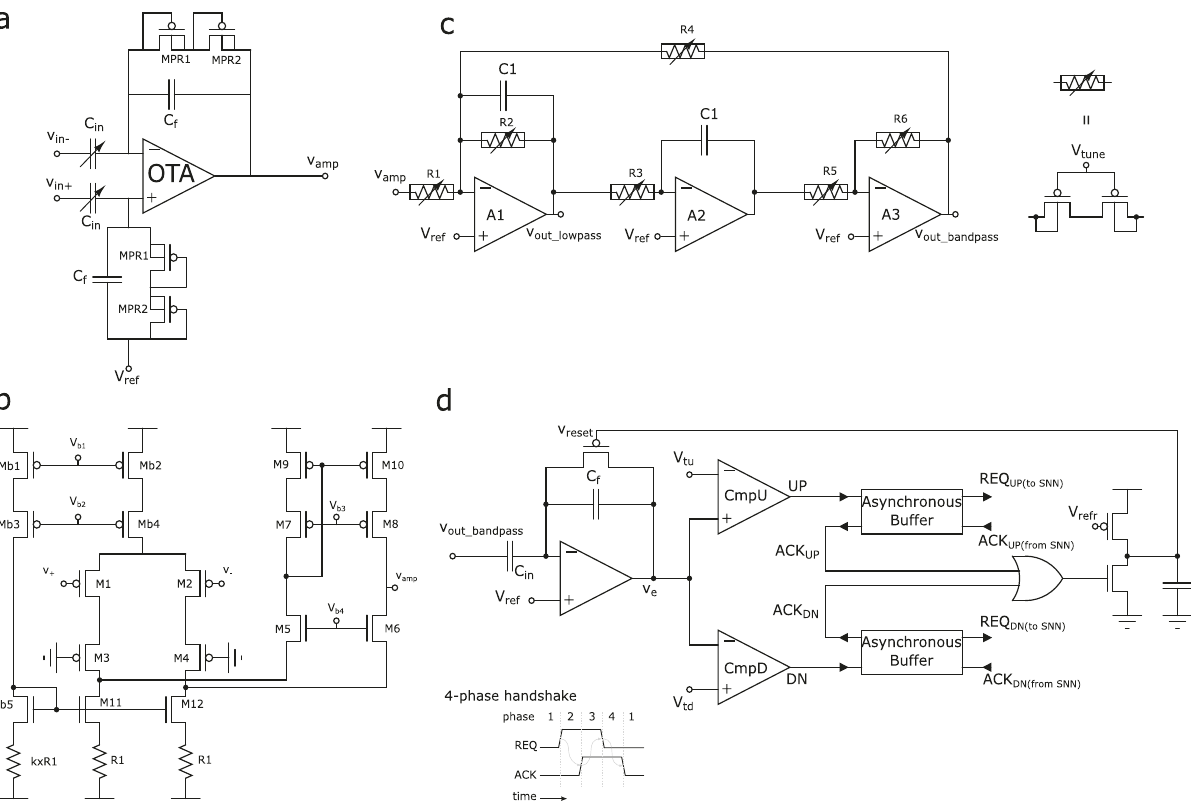
Fig. 3 Schematic diagrams of the input headstage circuits. a Variable-gain LNA using variable input capacitor array and pseudo-resistors. The gain of this stage is calculated by C in / C f ; the use of the pseudo-resistors allows to reach small low cut-off frequencies. b Folded cascode OTA using resistive degeneration to reduce the noise in fl uence of nMOS devices. Note that the current fl owing through the biasing branch, Mb 1- Mb 3- Mb 5- k × R 1, is k times smaller than the tail branch of the ampli fi er. c band-pass (Tow-Thomas) fi lters for performing second-order fi ltering in both ripple and fast-ripple bands as well as the low-frequency component of the iEEG. Tunable pseudo resistors are used to adjust the fi lter gain, center-frequency, and band-width. The same basic structure can be used to provide both low-pass and band-pass outputs, thus is desirable in terms of design fl exibility. d Asynchronous Delta Modulator (ADM) circuit to convert the analog fi lter outputs into spike trains. The ADM input ampli fi er has a gain of C in / C f in normal operation when V reset is low and the feedback PMOS switch is off. As the ampli fi ed signal crosses one of the two thresholds, V tu or V td , a UP or DN spike is produced by asserting the corresponding REQ signal. A 4-phase handshaking mechanism produces the corresponding ACK signal in response to the spike. Upon receiving the ACK signal, the ADM resets the ampli fi er input and goes back to normal operation after a refractory period determined by the value of V refr . The asynchronous buffers act as 4-phase handshaking interfaces that propagate the UP/DN signals to the on-chip AER spike routing network of Fig.